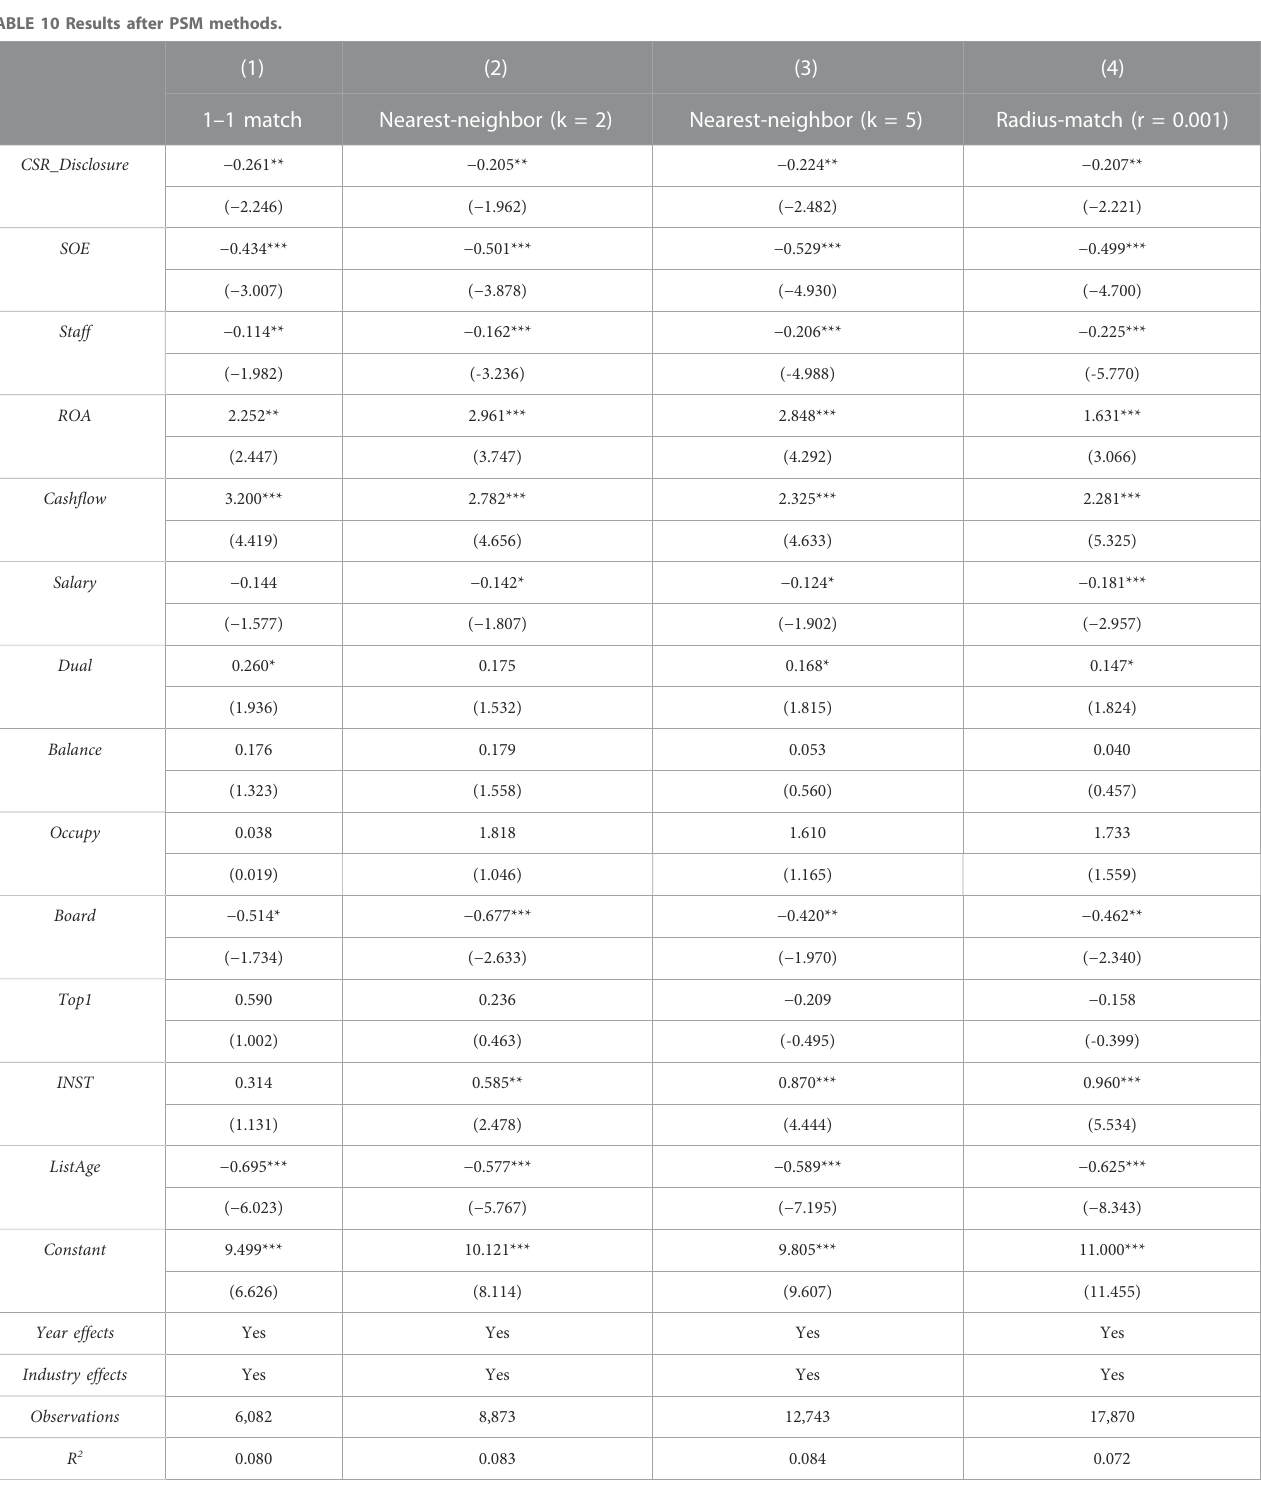
TABLE 10 Results after PSM